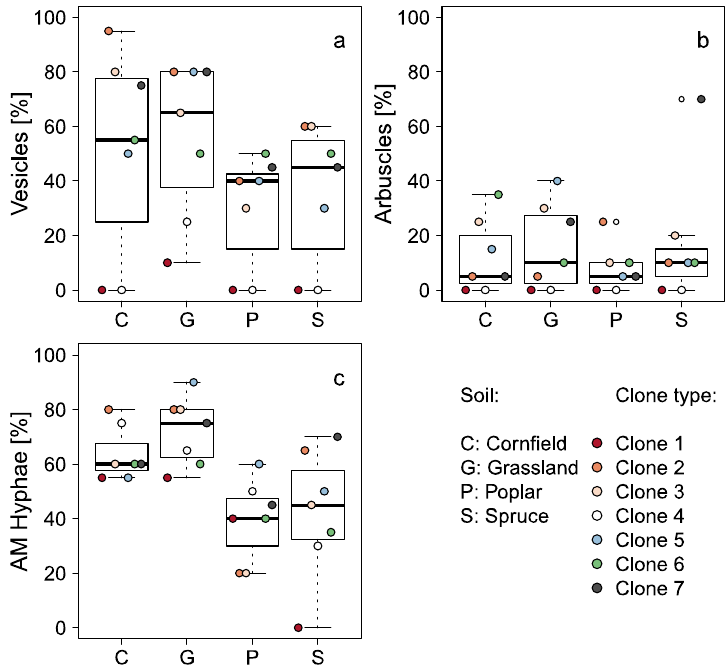
Figure 3. The degree of colonization by vesicles ( a ); arbuscules ( b ); and AM hyphae ( c ) (% in 10 cm root length) of seven poplar clones in the four different land use types (C = cornfield, G = grassland, P = poplar soil, S = spruce soil). The number of vesicles and arbuscules varied significantly among sites and poplar clones. (C1 = P. nigra (clone Fritzlar 2 Maserpappel); C2 = P. deltoids ; C3 = P. nigra × P. maximowiczi (clone Max 3); C4 = P. trichocarpa ; C5 = P. maximowiczii C6 = P. canadensis (clone ROBUSTA); C7 = P. maximowiczii × P. trichocarpa (clone Hybride 275